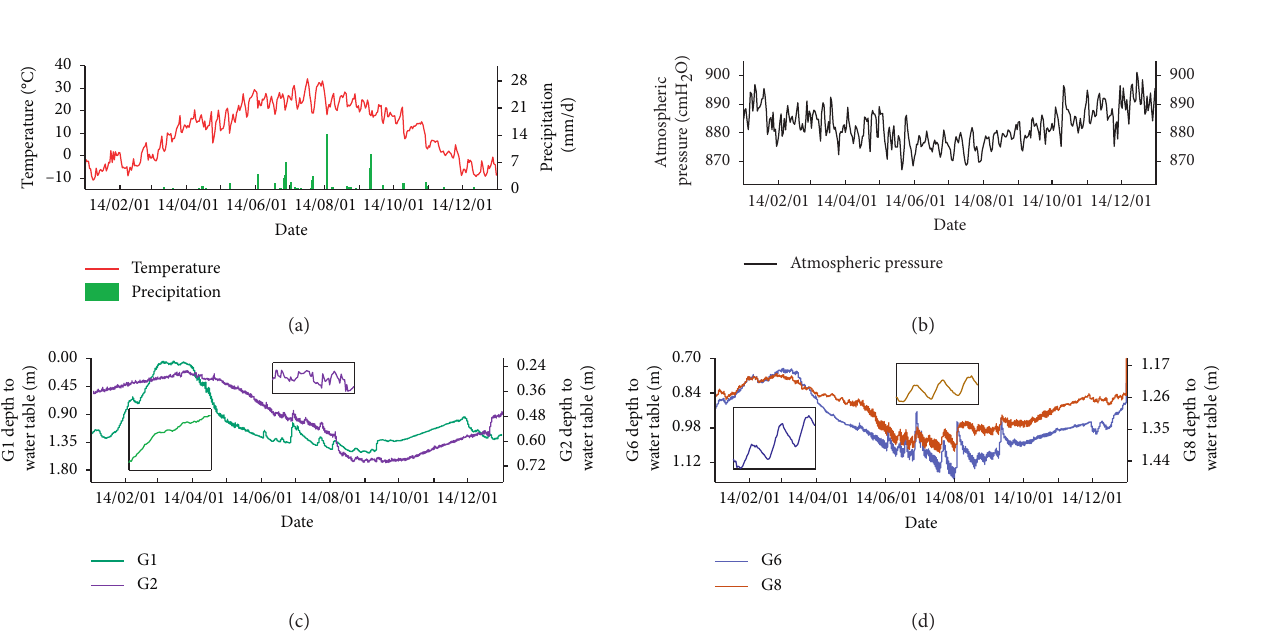
Table 1: Classification of observation sites based on diurnal groundwater level fluctuations and the main vegetation profiles near the observation sites. Well no. Main vegetation type Bare sand PA PA PA AS AS NT and AS NT and AS NT and AS